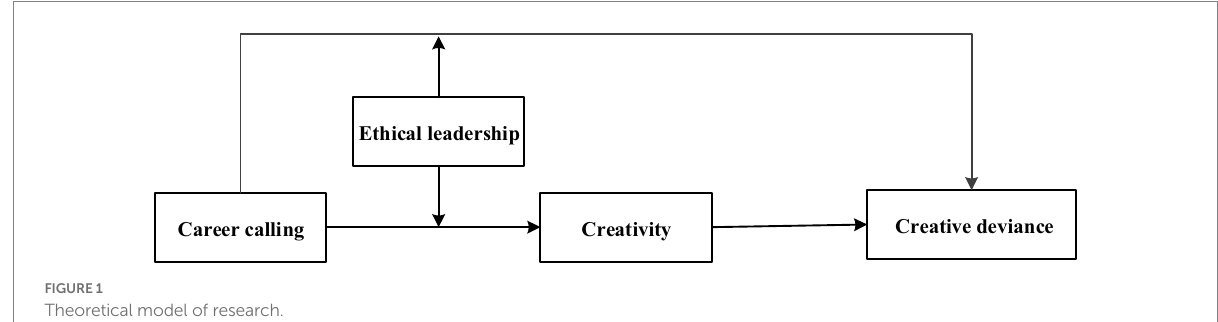
FIGURE 1 Theoretical model of